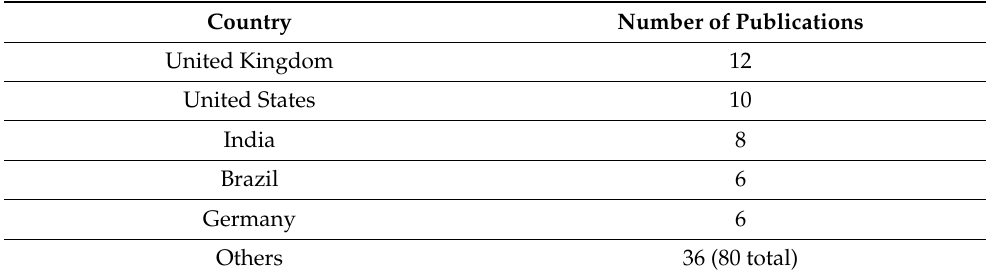
Table 2. Distribution of the articles according to the number of contributions of the countries. Country Number of Publications United Kingdom 12 United States 10 India 8 Brazil 6 Germany 6 Others 36 (80